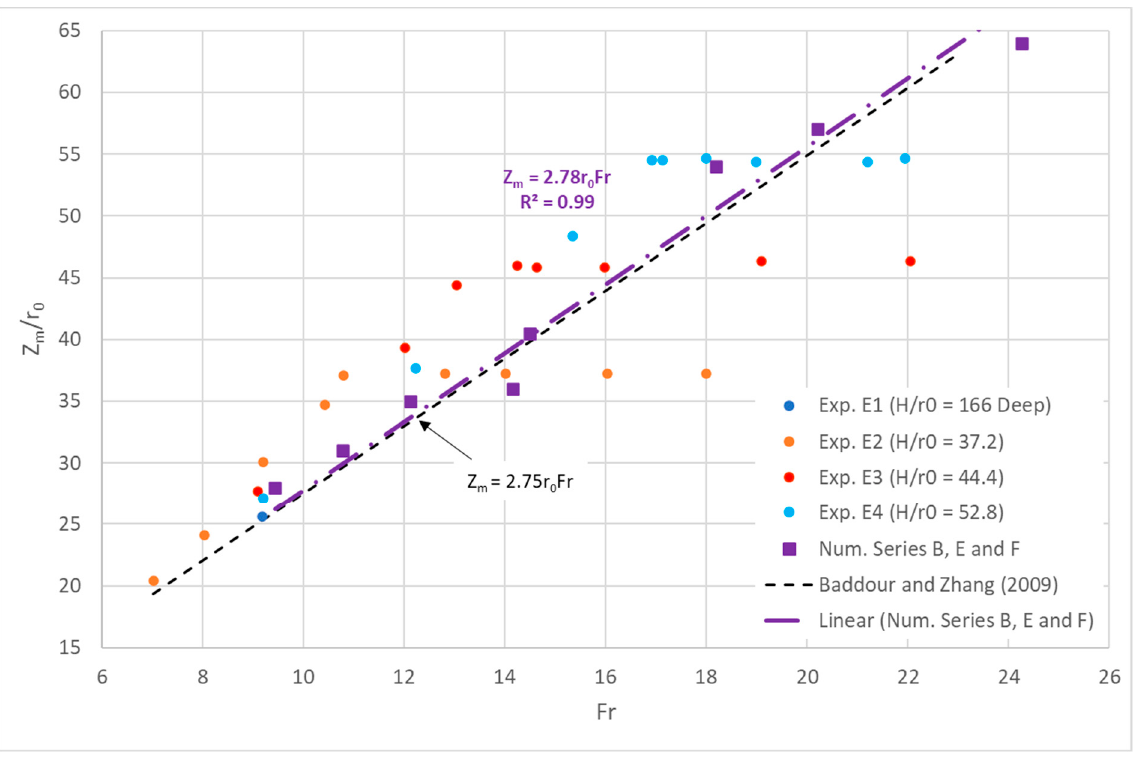
Figure 9. Discharge maximum rise under fixed ambient water depths and variable Froude number [6].